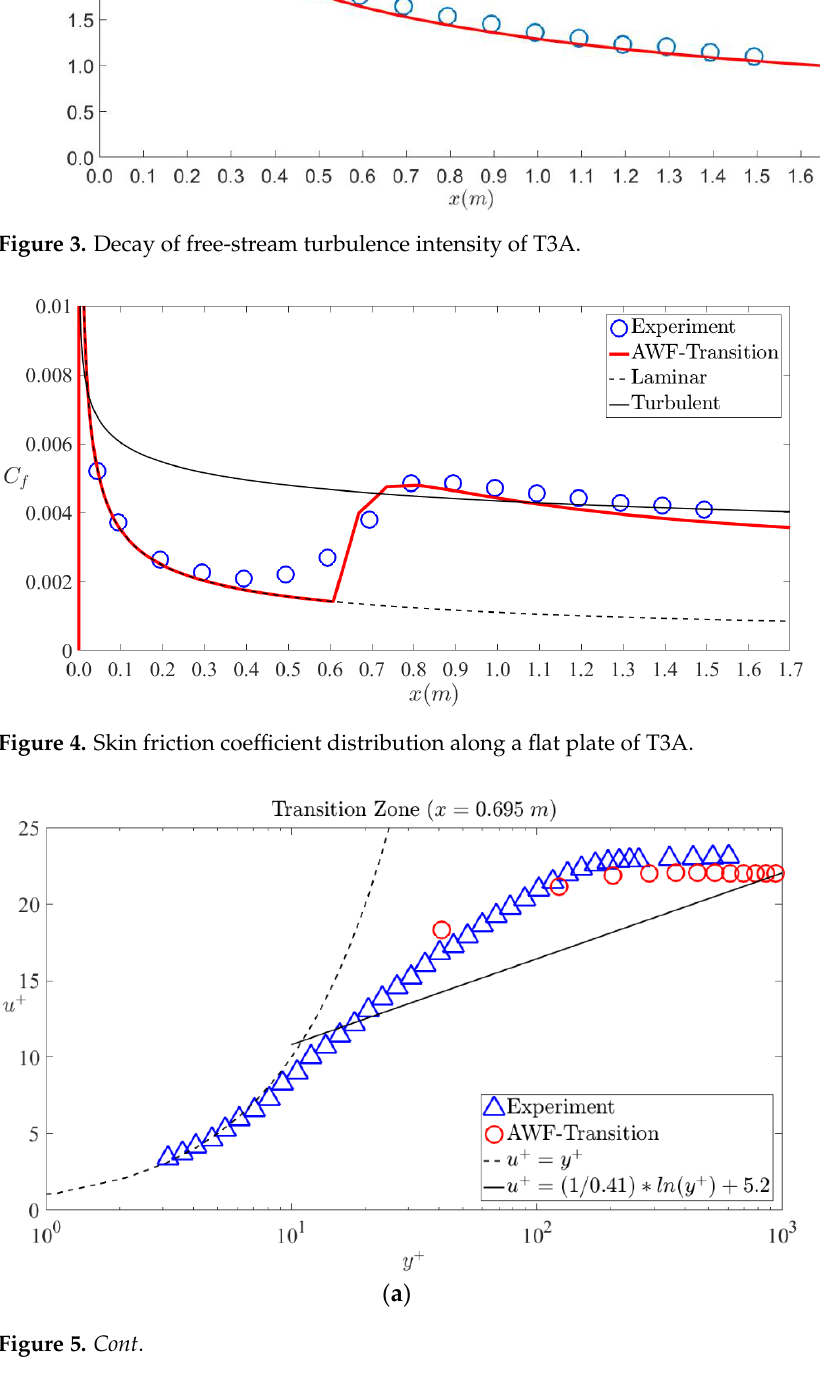
Figure 3. Decay of free-stream turbulence intensity of T3A.